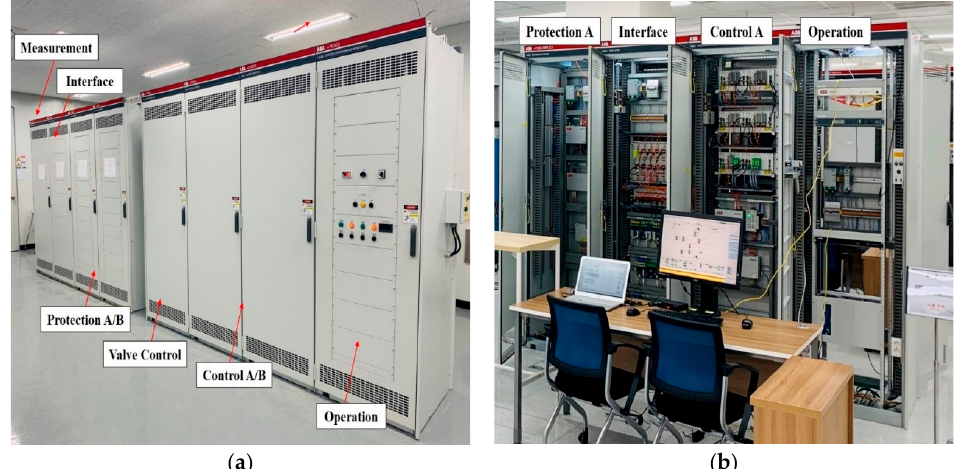
Figure 5. TCSC controller. ( a ) Actual controller in field operation. ( b ) Replica controller located in the lab.